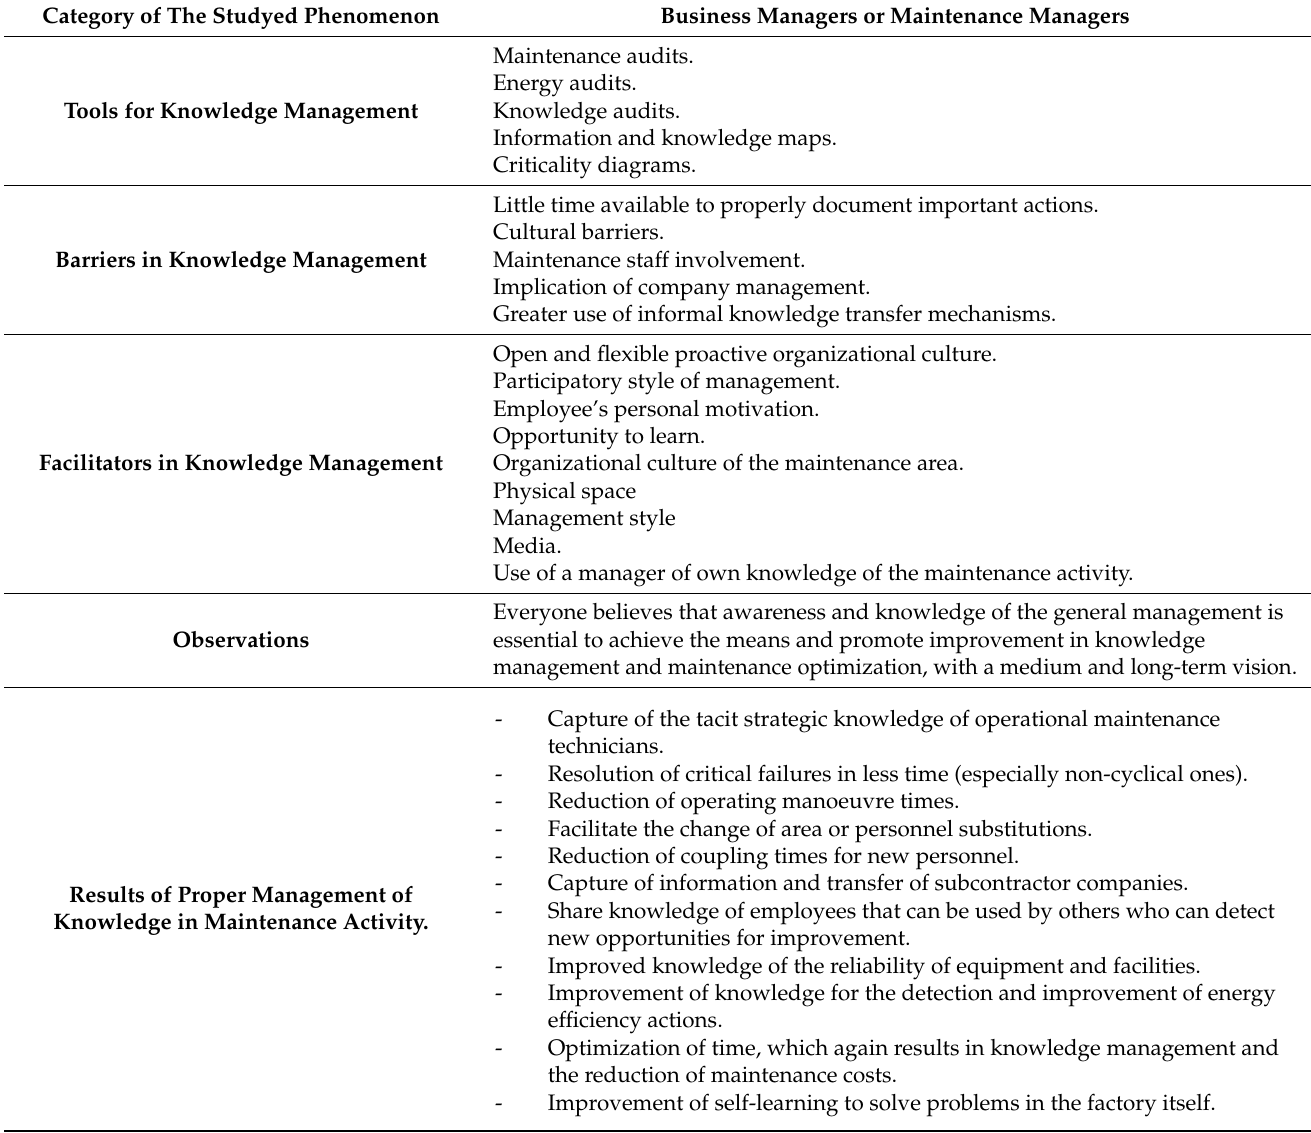
Table 3. Tools, barriers and facilitators in knowledge management in maintenance activity from the point of view of the company